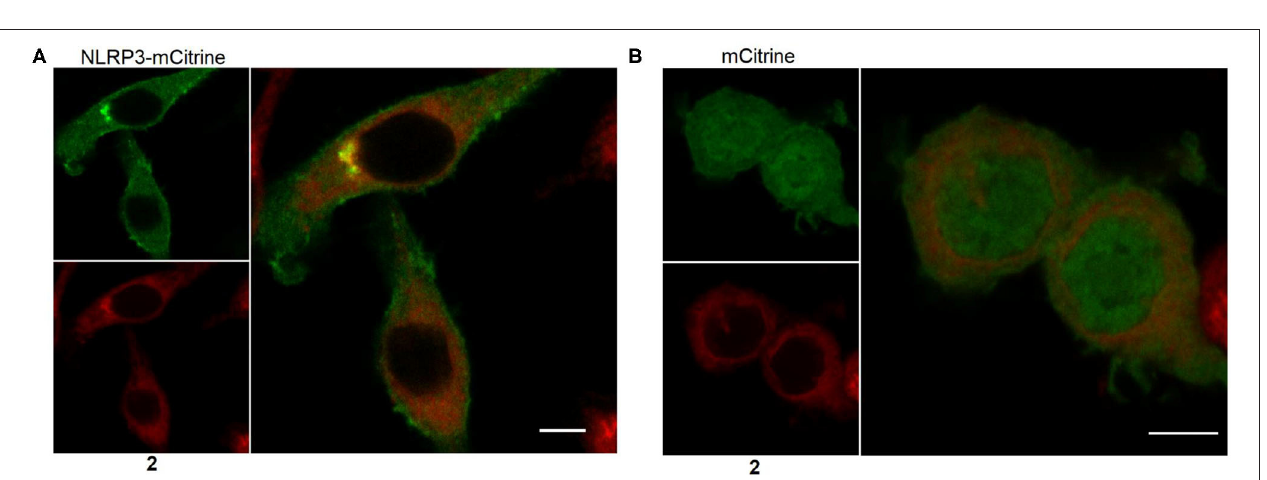
FIGURE 6 | Representative microscopic images showing NLRP3 in immortalized murine macrophages overexpressing NLRP3 fused to mCitrine (A) or overexpressing mCitrine (B) . Cells were treated with 5 µ M of probe 2 for 30min. Wavelengths for excitation / emission were as follows 516nm / 529nm for mCitrine and 393nm / 509nm for coumarin 343. The experiment was performed three times. The bars indicate 5 µ